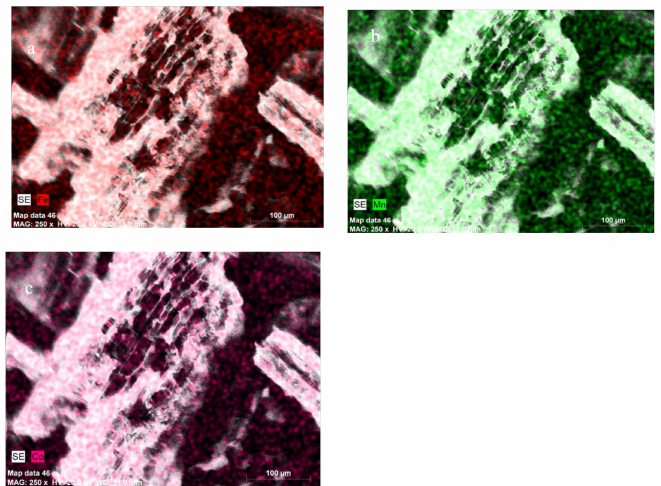
Figure 3. Scanning electron microscope (SEM) images of wheat straw biochar surface and energy dispersive X-ray spectroscopy (EDX) mapping. ( a ) Fe; ( b ) Mn; and ( c ) Co ions, distribution on the biochar produced from wheat straw (WSBC)